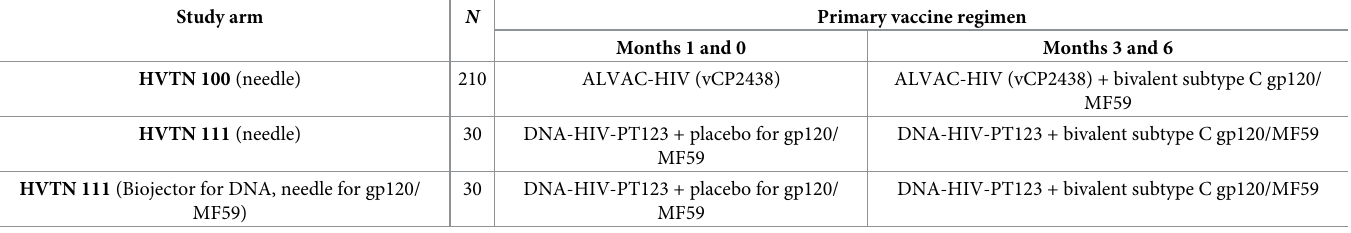
vaccine or placebo in a ratio of 5:5:1:5:5:1 (vaccine:vaccine:placebo using needle and syringe for DNA plasmid administration and vaccine:vaccine:placebo using Biojector2000 [Bioject Medical Technologies, Tigard, Oregon] for DNA plasmid administration). The statistical Table 1. Study schemas for comparator vaccine arms of HVTN 100 and HVTN 111 (the placebo arms in each trial consisted of n = 42 in HVTN 100 and n = 6 in each of the 2 placebo arms of HVTN 111). Study arm